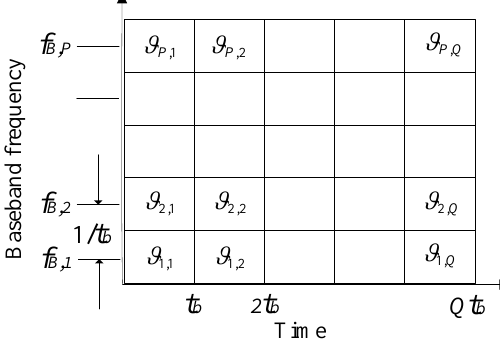
Figure 1. The structure of an OFDM signal in time domain.